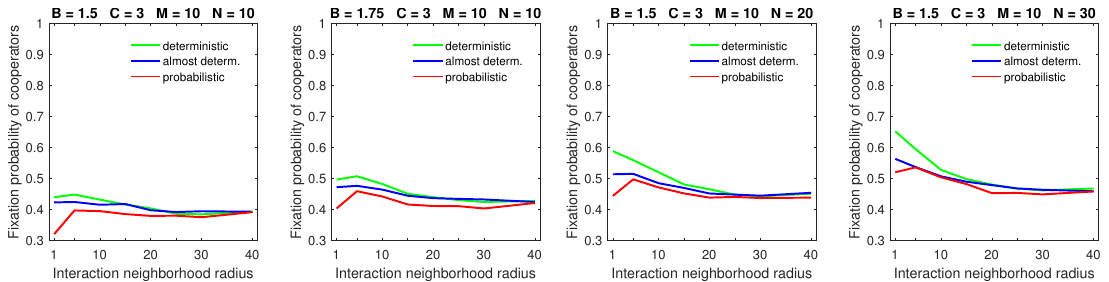
Figure 13. Deterministic dispersal models avoid the breakdown of cooperation, which was observed in the probabilistic model for sparse populations with a small benefit-to-cost ratio, small interaction neighborhoods, a high mobility rate, and large dispersal neighborhoods. In all graphs, R =